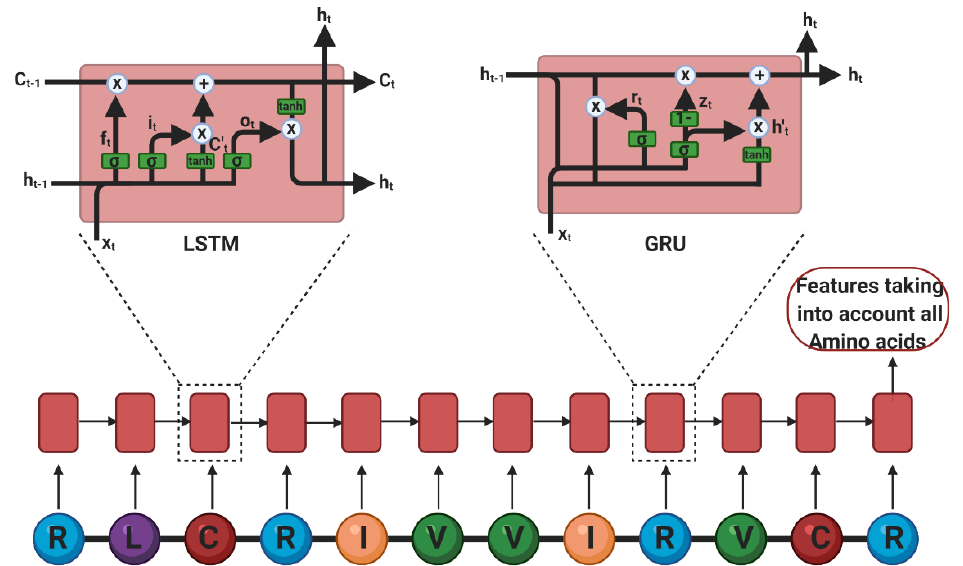
Figure 3. Recurrent neural networks used for peptide property prediction. A representation of each of the amino acids is input to one unit of the recurrent network. The last unit’s output contains information considering the output of the previous ones, therefore considering the whole sequence. On the left a long-short term memory networks (LSTM) unit representation and on the right a gated recurrent units (GRU) unit representation. (Created with BioRender).